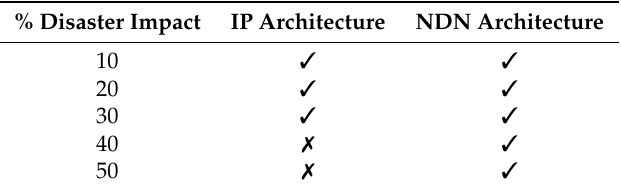
Table 1. Communication architecture